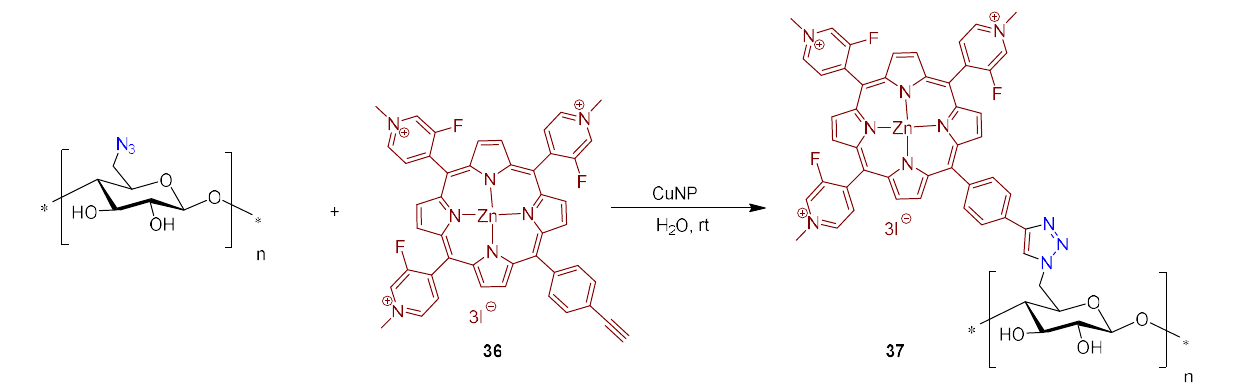
Figure 25. Synthesis of cellulose fluoro triazole-porphyrin conjugate 37 by “ click chemistry ” approach (Adapted from Ref. [172] ).